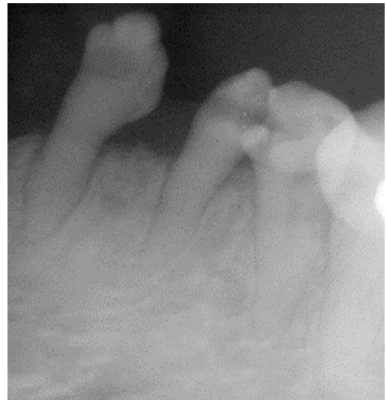
Figure 5. Radiographs of 33, 34 and 35 showing the small size of the roots of the canines and premolars and the abnormal dental morphology of their clinical crowns.